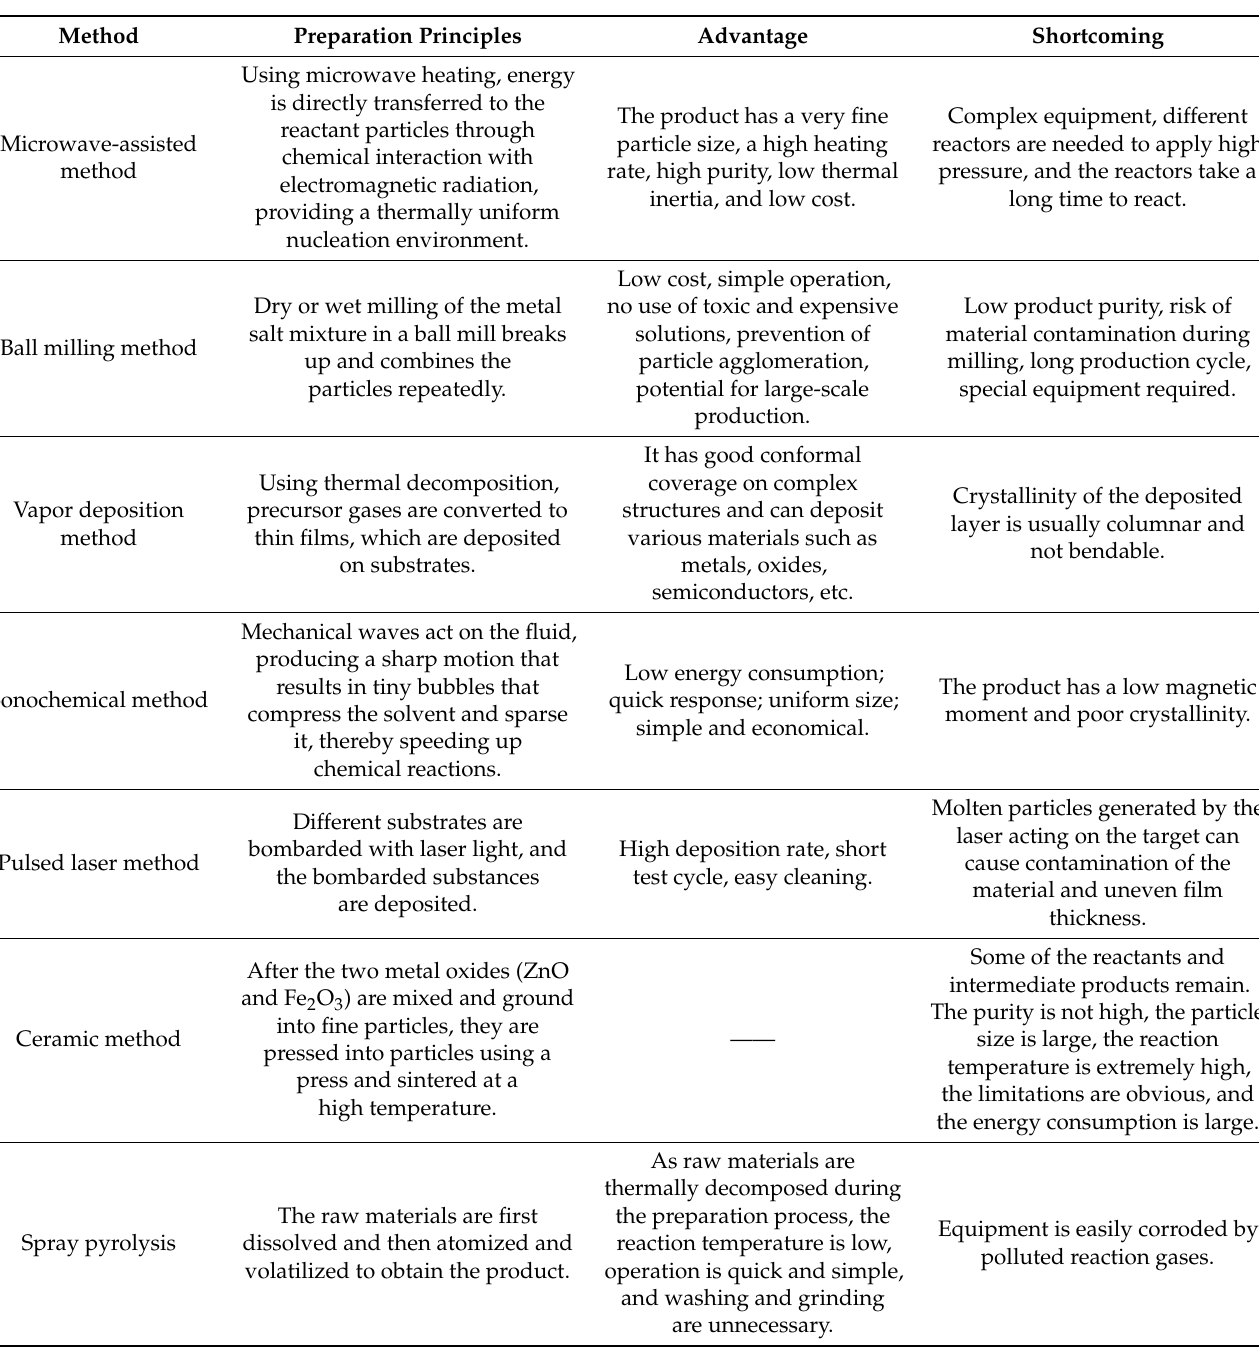
Table 2. The principles and the advantages and disadvantages of the different methods used to prepare the ZnFe 2 O 4